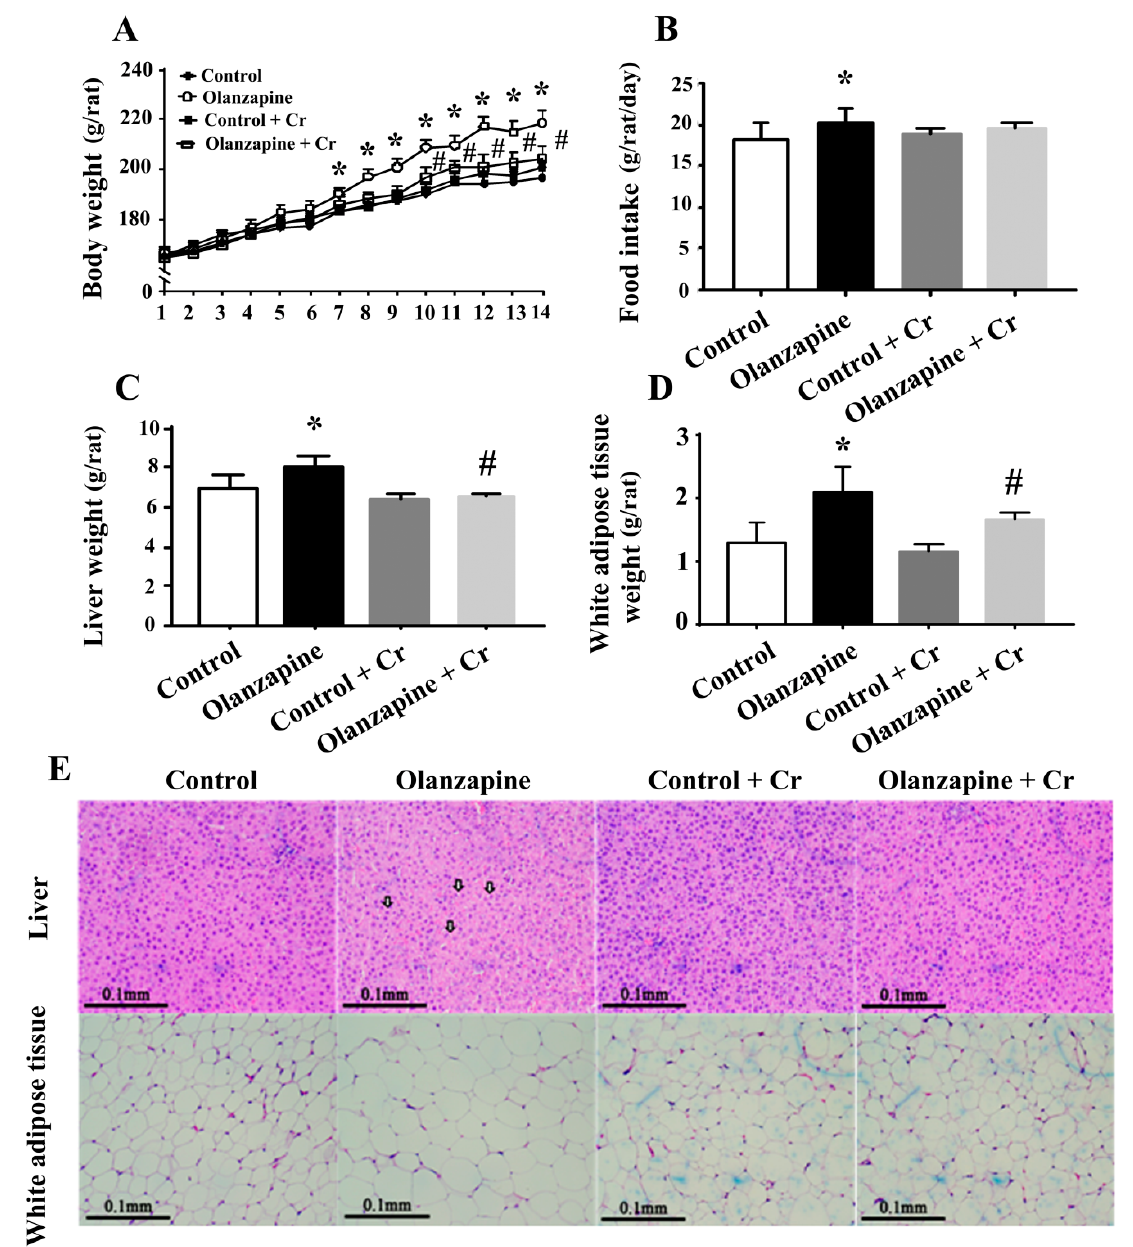
Figure 5. Chromium improved olanzapine-induced weight gain. During a course of 14 days, body weight and food intake were recorded over time. Daily changes in body weight ( A ) and food intake ( B ) were summarized and depicted. At the end of the experiments, the weight of the excised liver ( C ) and white adipose tissues ( D ) was measured. ( E ) The excised liver and perirenal white adipose tissues were subjected to histological examination. Representative photomicrographs of H&E stain are shown. * p < 0.05 vs. control and # p < 0.05 vs. olanzapine control, n = 10. Scale Bar: 0.1 mm. Arrows indicate a deposition of lipid droplets.